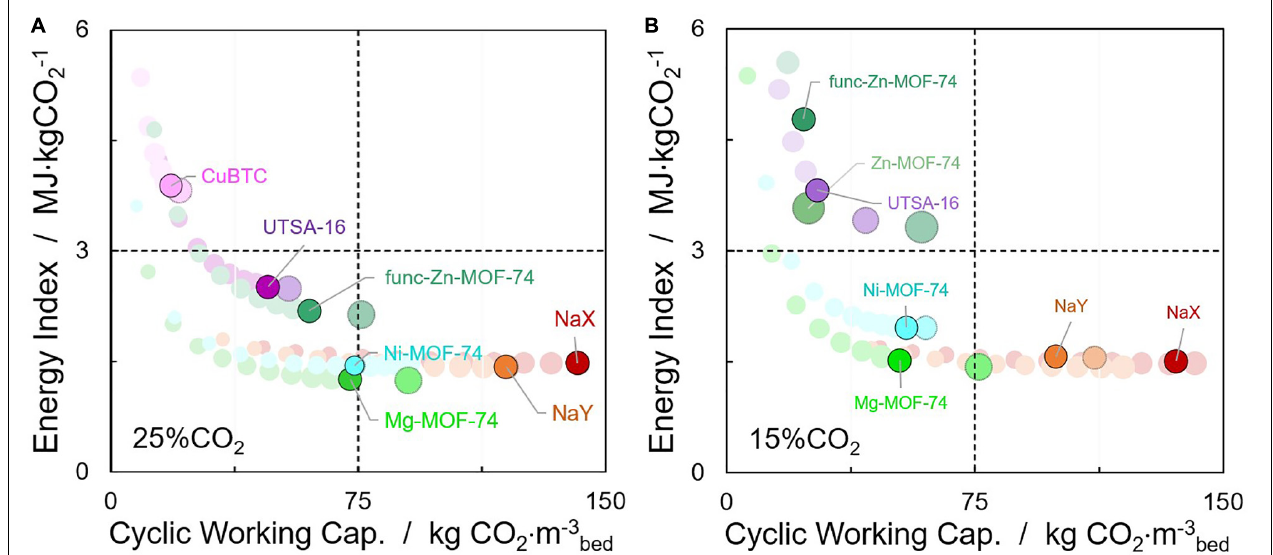
FIGURE 7 | Estimated evolution of cyclic working capacities and energy indexes of adsorbent materials achieving purities > 90% for temperature swing adsorption (TSA) process with (A) 25% CO 2 /75% N 2 and (B) 15% CO 2 /85% N 2 binary mixtures. Sphere size related to the desorption temperature ( T ads = 313 K). Highlighted spheres correspond to a regeneration temperature of 403 K, while dashed spheres indicate optimized values at higher desorption temperatures. Binary 5% CO 2 /95% N 2 composition plot have been omitted since none of the materials allow achieving the specified